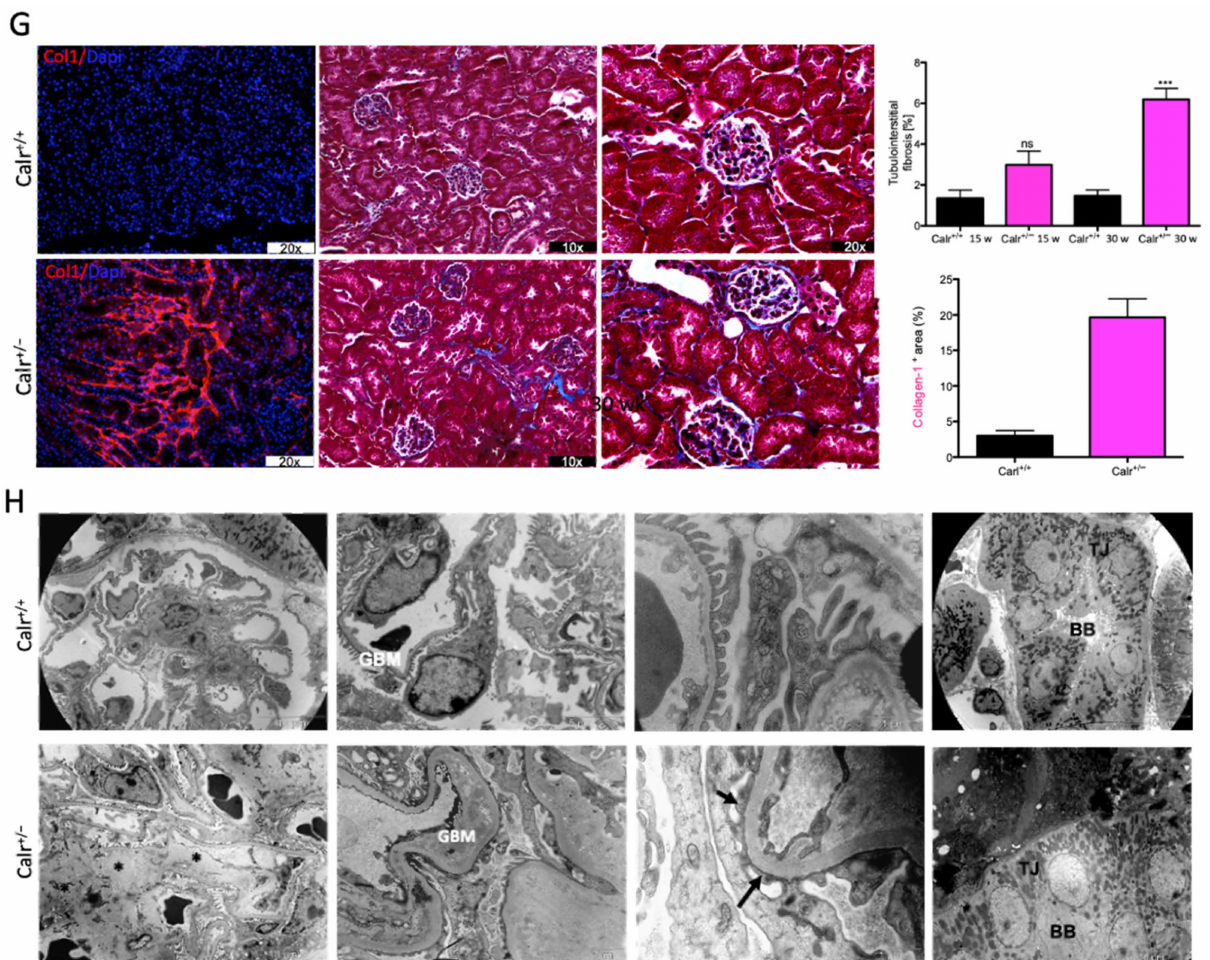
Figure 1. Progressive structural alterations in Calr +/ − mice. ( A ): Illustration of the experimental design for structural investigation of the kidney. ( B ): Western blot analysis of Calr abundance in Calr +/+ and Calr +/ − mouse kidney showing a > 50% reduction in Calr expression in Calr +/ − mouse kidney. Paraffin-embedded kidney sections (3 µ m) were stained with PAS to compare the kidney structures of Calr +/+ and Calr +/ − at 15 wk, 30 wk, and 40 wk of age (**: p < 0.01). ( C ): Representative glomeruli of PAS-stained sections from Calr +/+ and Calr +/ − mice (magnification × 40); upper bar diagram shows an increase in mGA in the kidneys of 30 and 40 wk old Calr +/ − mice in comparison to those of young Calr +/ − and Calr +/+ mice of the same age ( p < 0.05). Lower bar diagram shows a significant increase in mMA in 40 wk old Calr +/ − mice compared to young Calr +/ − mice of 15 and 30 wk old and Calr +/+ mice of same age. The data shown are mean ± SE ( n = 30 glomeruli per group, p < 0.05). PAS: periodic acid–Schiff; mGA: mean glomerular area; mMA: mean mesangial area. ( D ): Kidney section from 40 wk old mouse kidney stained with different methods confirming advanced kidney injury in Calr +/ − mice. ( E ): Western blot analysis of Fin and Lam showed a high expression in Calr +/ − mouse kidney compared to Calr +/+ . Bar diagram represents the quantification of the Western blot results shown in ( E ), ( n = 4. ***: p < 0.001, ns: non-significant, p > 0.05). β -actin (Actb) was used as loading control. ( F ): Representative images of kidney section from Calr +/+ and Calr +/ − mice, staining of the kidney sections with antibodies against fibronectin (Fin1), and laminin. ( G ): Immunofluorescence staining with antibody against collagen I, MTC staining of kidney sections from Calr +/+ and Calr +/ − mice. The staining showed a significant marked increase in fibronectin, laminin, and collagen expression in the Calr +/ − kidney. ( H ): Kidney sections from 40 wk old Calr +/+ and Calr +/ − mice were assessed by electron microscopy. GBM: glomerular basement membrane; BB: brush borders; TJ: tight